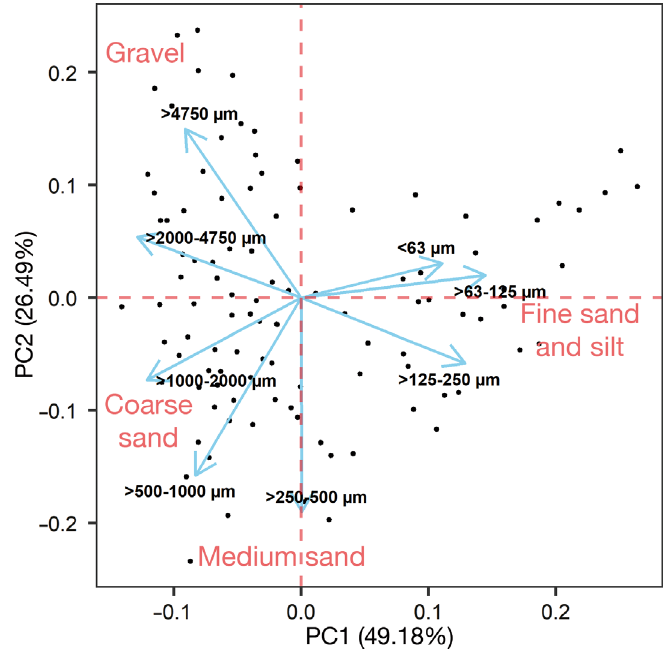
Fig. 2. Principal component analysis results for 8 size classes of sediment grain size across 18 sites. PC1 and PC2 account for 75.7% of the variance with loadings plot indicating which specific grain size classes (in µm) accounted for varia- tion along each axis. Sediment size categories according to Wentworth (1922) are indicated to demonstrate how the grain size data grouped in multi-dimensional